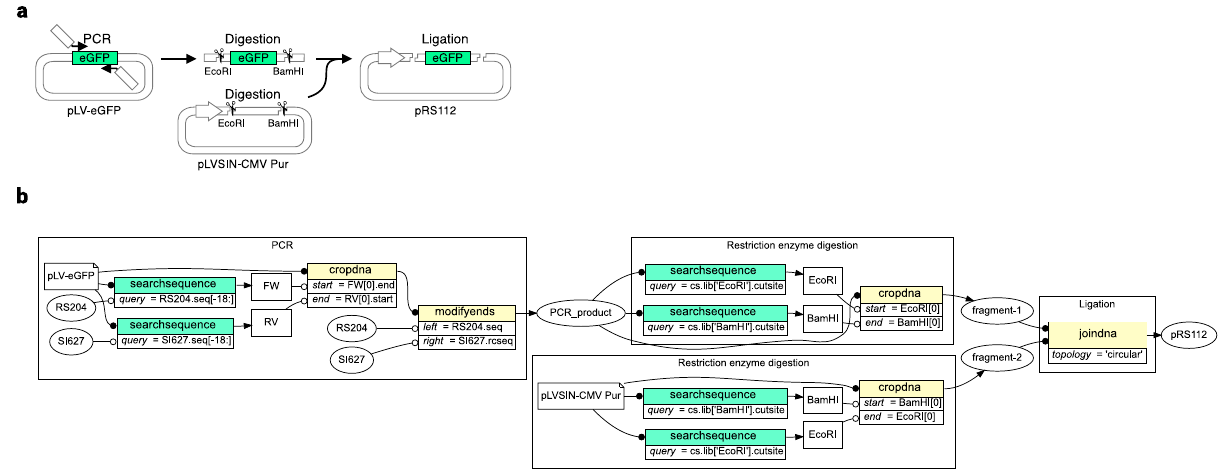
Fig. 3 Simple molecular cloning. a Conceptual diagram representing the cloning of eGFP into a lentiviral plasmid backbone. b QUEEN operational fl ow representing the same DNA cloning process. The visualization was directly generated from the output gbk fi le using QUEEN. The fi le shape, round, and uncolored rectangular objects represent the input gbk fi les, dsDNA objects, and feature objects, respectively. Colored boxes represent QUEEN operational functions with the colors corresponding to Fig. 2. Open and closed circle-headed lines represent information fl ows as QUEEN objects and input parameters,